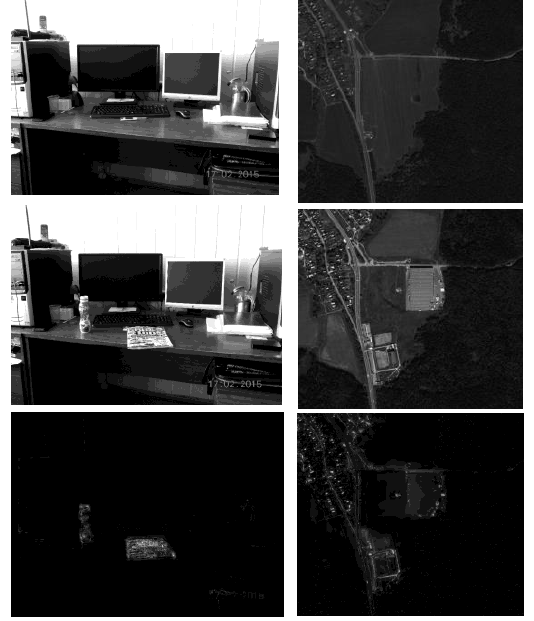
Figure 4. Examples of morphological difference map based on guided contrasting: first row – reference images; second row – test images; third row – morphological difference maps.